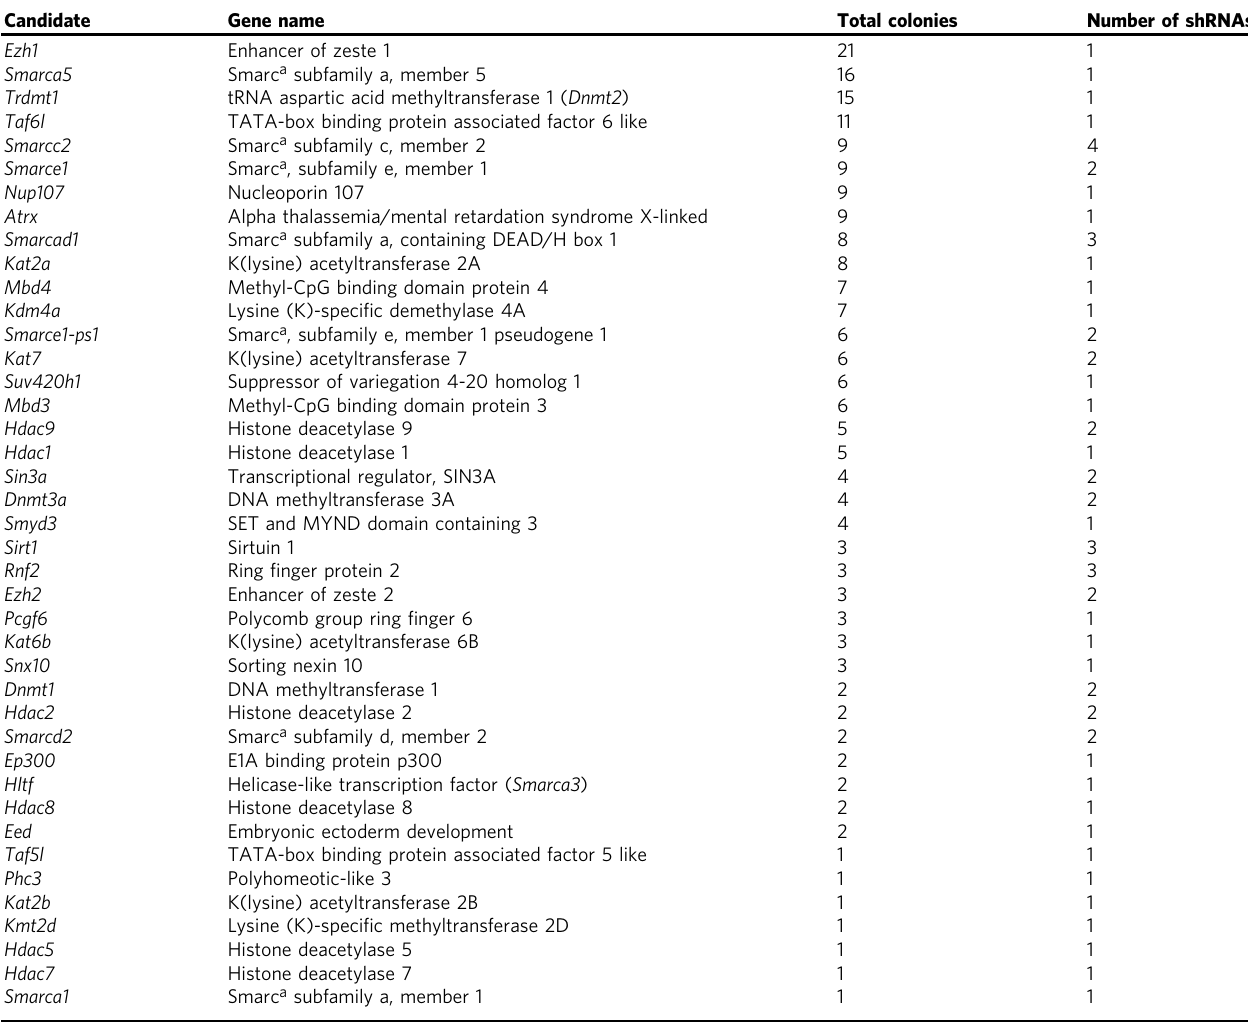
Table 1 Candidate epigenetic factors of the Kcnq1ot1 imprinted domain